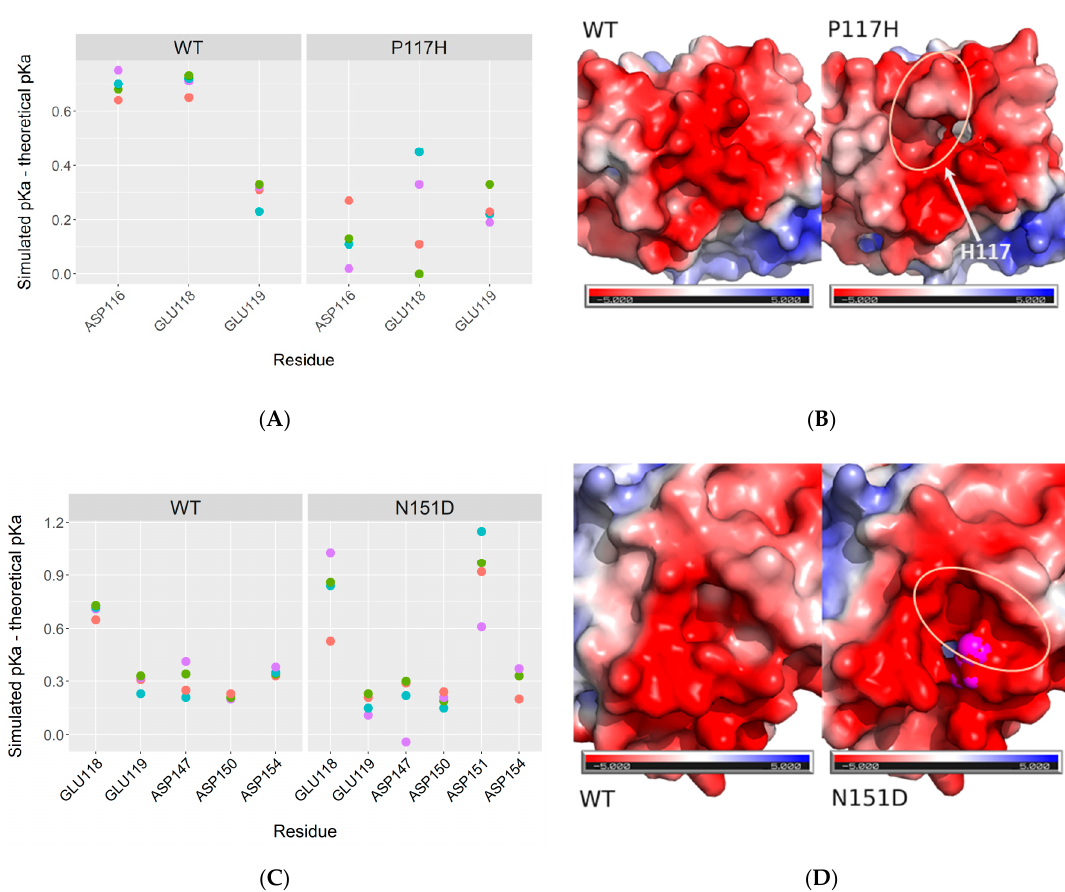
Figure 4. Electrostatics effects of the P117H and N151D mutations. Panels A , C present the variations of pKa of the surrounding aspartates and glutamates of P117H and N151D, respectively. pKas values were calculated on the average structures generated with four independent molecular dynamics simulations for wild-type (WT), P117H (P117H), or N151D (N151D) with the propka options of the pdb2pqr software, using a pH = 7.5 value and the AMBER force field. Theoretical pKa values of aspartate (3.8) or glutamate (4.5) were then subtracted from the simulated ones. Panels B , D present a mapping of the electrostatic potential onto the solvent excluded surface of P117H (Panel B) or N151D (Panel D) mutants compared to the wildtype FD. In panel B, the arrow represents the position of the H117 residue (hidden by the surface). In panel D, the magenta surface corresponds to the D151 residue. In panels B and D, the light orange oval shows the locations of the electrostatic potential and surface changes. Electrostatic potentials were calculated on the average structure of simulation 1 with the APBS module of Pymol using defaults parameters. The color scale is indicated below each surface and is in kT/e.